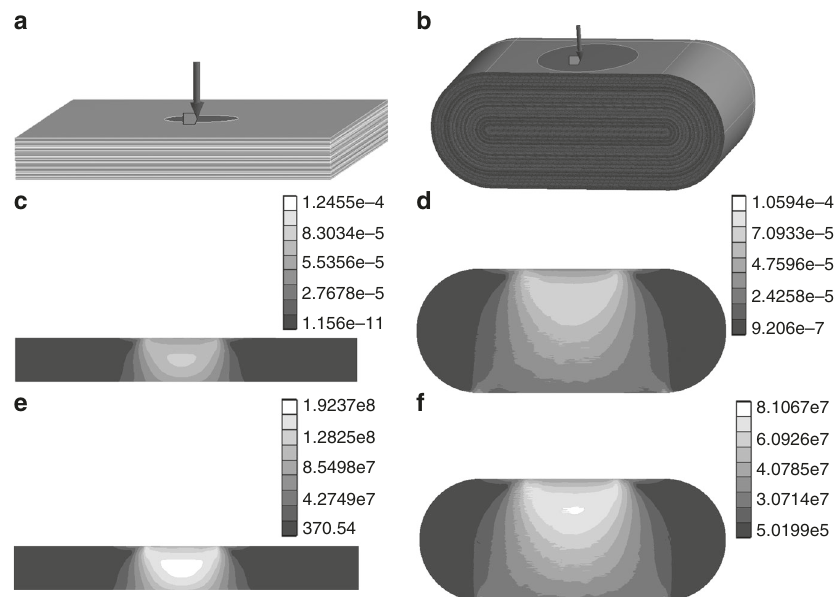
Fig. 7 Models showing the strain and stress distributions on the hBN fl ake and BN onion. Models of hBN fl ake ( a ) and BN onion ( b ); equivalent elastic strain of hBN fl ake ( c ) and BN onion ( d ); equivalent stress of hBN fl ake ( e ) and BN onion ( f